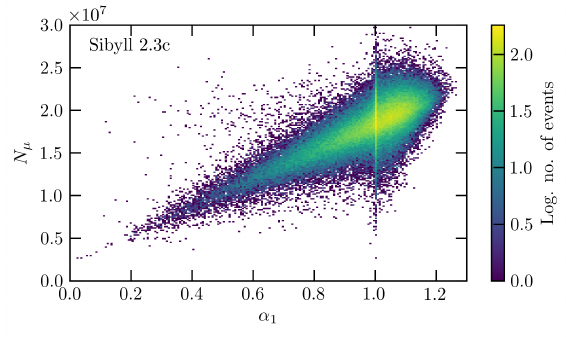
Figure 4. Distribution of α 1 and the number of muons at ground in proton induced air showers with a primary energy of 10 19